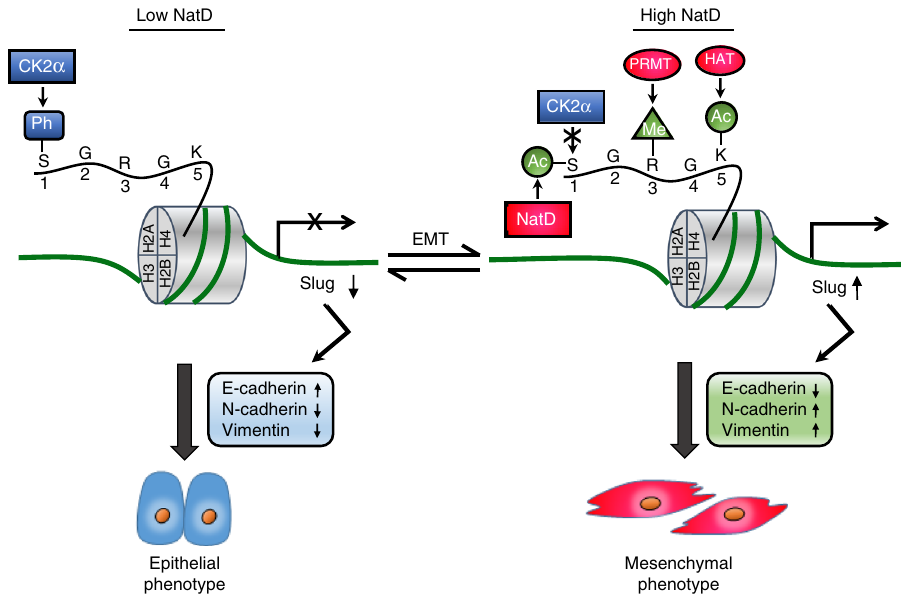
Fig. 8 Model for the role of NatD in EMT. In human lung cancer cells, when NatD levels are low, CK2 α phosphorylates histone H4S1, which silences Slug expression, retaining tumor cells in the epithelial state. When NatD levels are high, NatD acetylates histone H4 serine 1 (S1), which blocks CK2 α -mediated S1 phosphorylation, and allows arginine 3 (R3) methylation and lysine 5 (K5) acetylation to activate Slug gene expression, promoting EMT to generate mesenchymal tumor cells, which increases cancer cell invasion and metastasis. PRMT protein arginine methyltransferase, HAT histone